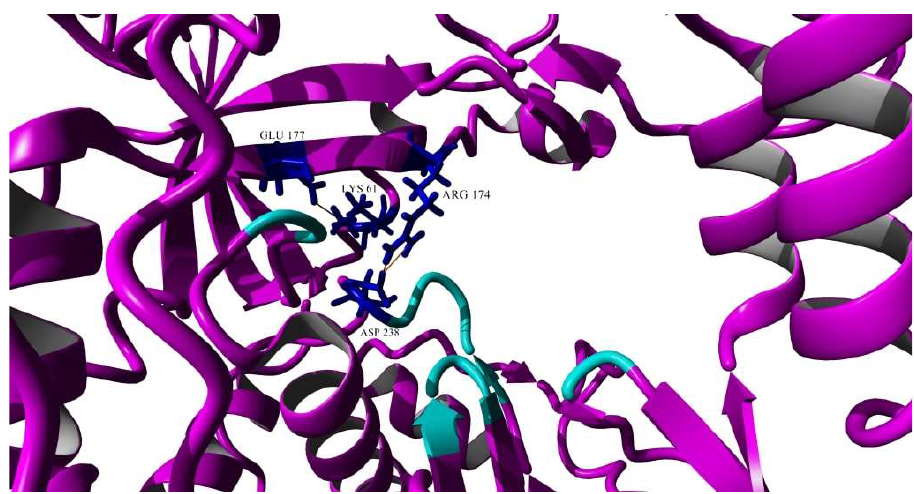
Figure 11. Three additional salt bridges found in the EV-A71/SP 3D polymerase surrounding the active site that could affect the structure and function. A salt bridge formed between Lys61-Glu177 was found in the EV-A71/SP variant. Two salt bridges were formed between Arg174-Asp238 (colored in blue) in the EV-A71/SP variant.